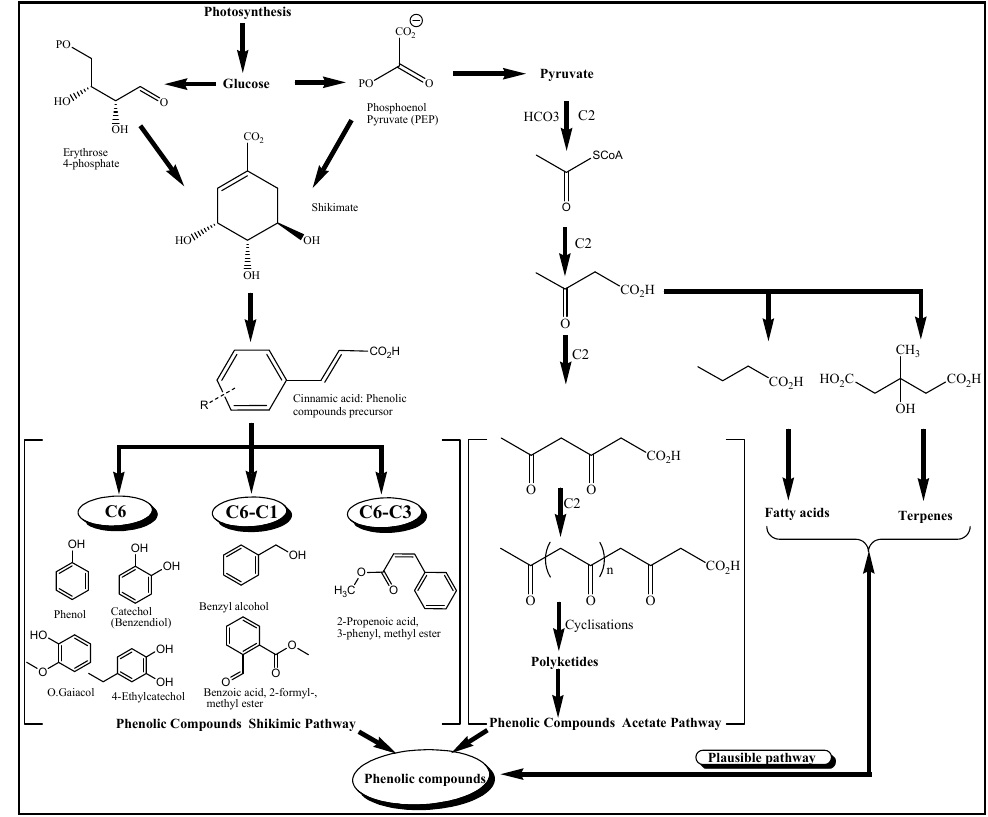
Figure 3. Interconnection of the biosynthetic pathways of the different chemical classes present in VF and EO.